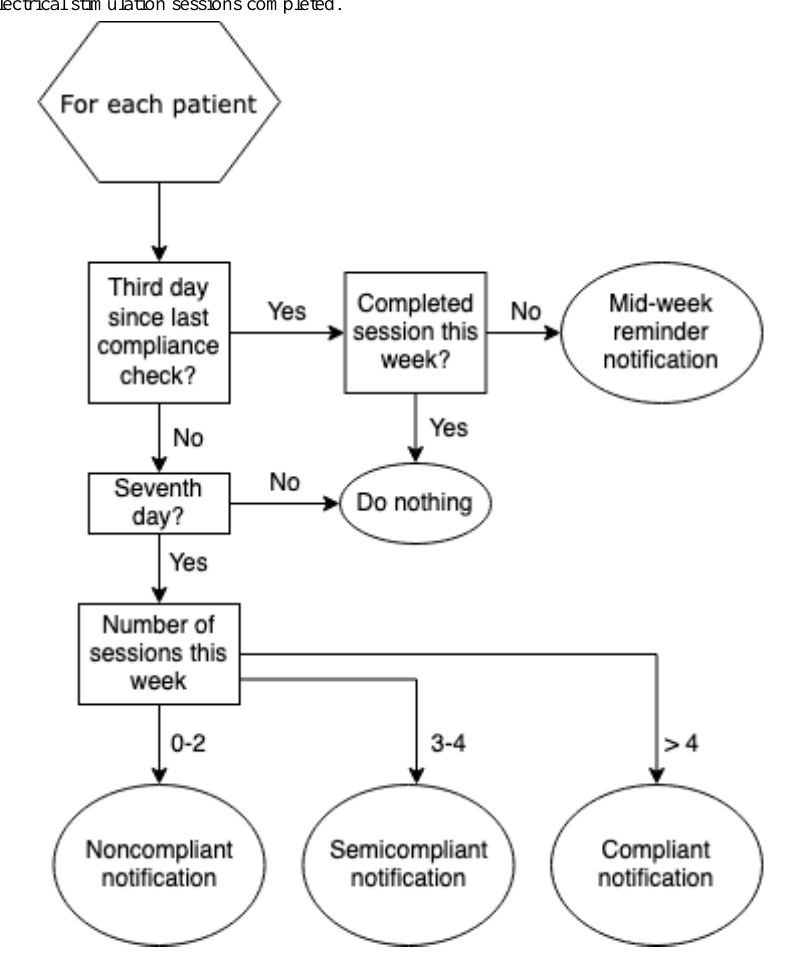
Figure 4. Patient adherence evaluation algorithm. Adherence is checked twice weekly. Positive and remedial push notifications are sent based on the number of neuromuscular electrical stimulation sessions